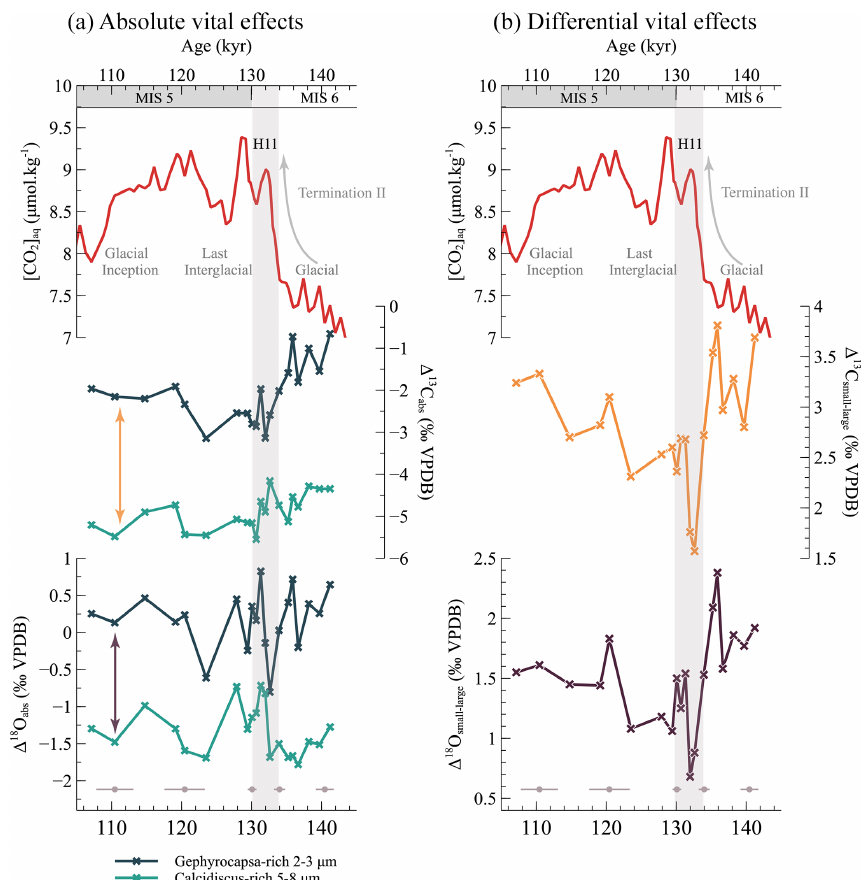
Figure 3. Expression of the coccolith vital effects, both absolute (a) and differential (b) , across Termination II. Panel (a) : the magnitude of the coccolith absolute vital effect seems to be dependent on coccolith size. Arrows in panel (a) represent the differential vital effects represented in the associated panel (b) : the differential vital effect in both carbon and oxygen isotopes is less marked during the interglacial with high aqueous CO 2 concentrations than during the glacial